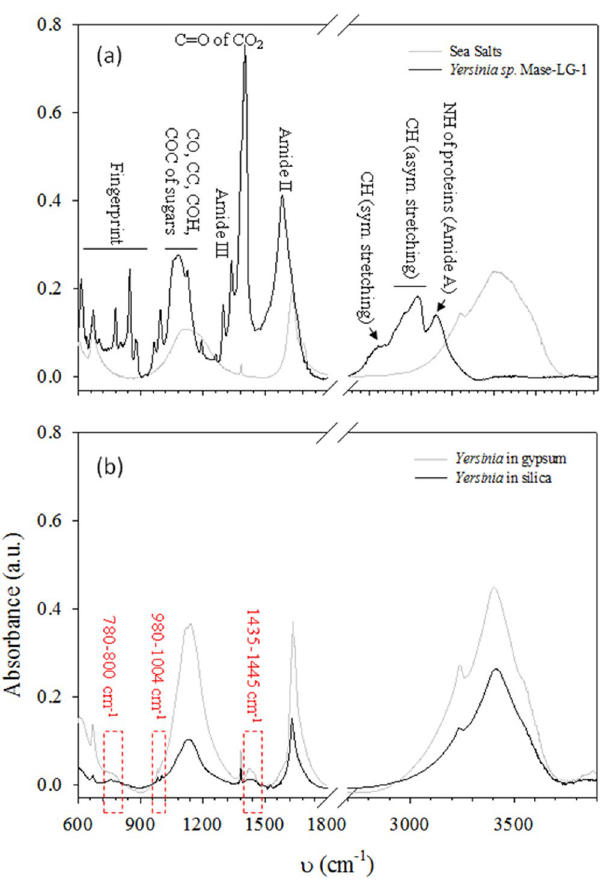
Figure 2. FTIR spectra of mineralized and non-mineralized cells. ( a ) FTIR spectra of controls, either positive with fresh Yersinia cells (black line), or negative for sea salts + gypsum + silica (grey line). ( b ) FTIR spectra of Yersinia after 6 months mineralization either in silica (black line) or in gypsum (black line). The three regions without absorption features in the negative controls are highlighted in